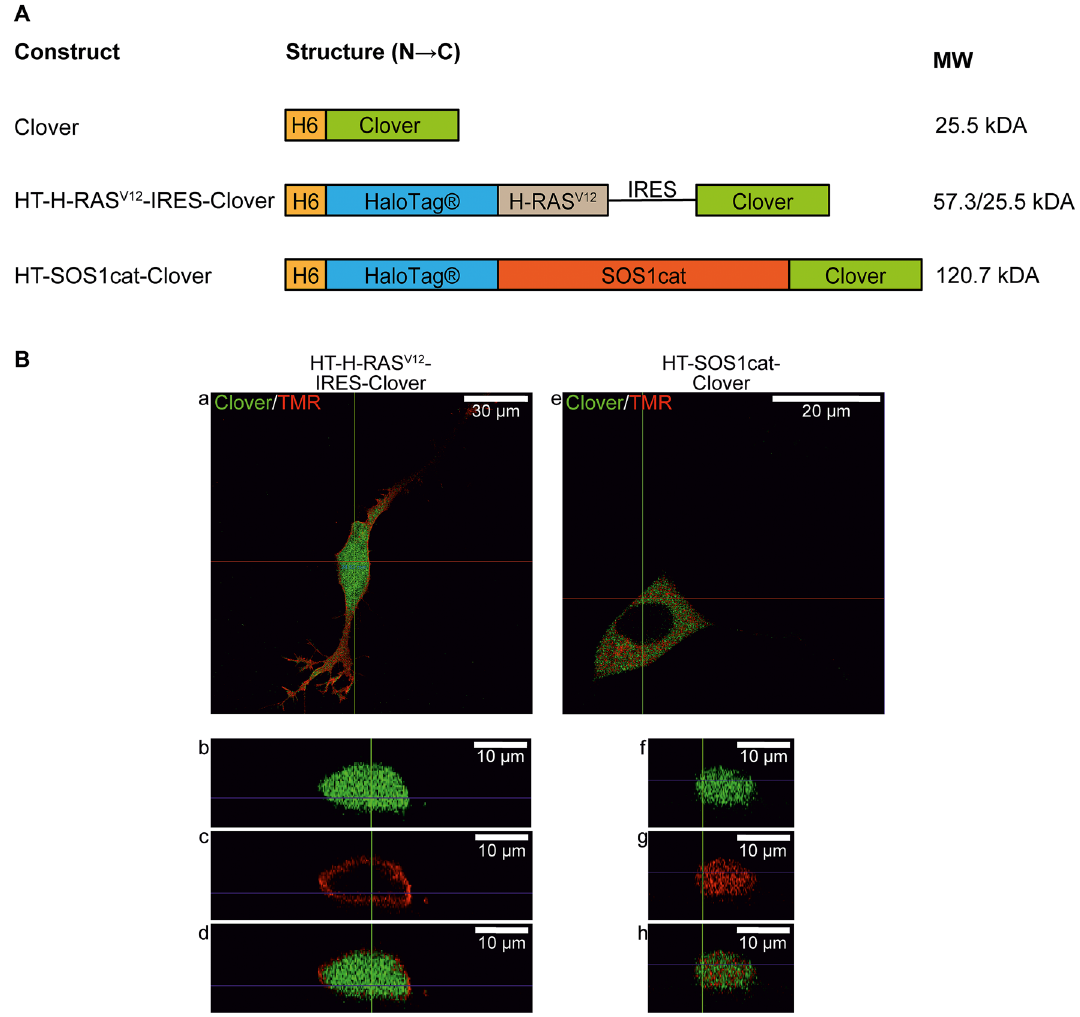
Figure 2. Domain structures of the constructs and intracellular distribution of expressed recombinant fusion proteins. ( A ) Constructs of the proteins. H6 poly(6)histidine tag, H-RAS V12 Harvey-RAS V12 , IRES Internal Ribosome Entry Site, SOS1cat catalytic domain of son of sevenless 1. ( B ) Confocal imaging of SH-SY5Y cells transfected with either HT-H-RAS V12 -IRES-Clover (a–d) or HT-SOS1cat-Clover (e–h) after in-cell binding of the red-fluorescent cell-permeable dye TMR-HTL 2 days after the transfection. Overlay images derived from green and red fluorescence channels are shown (a,e), and cross-sections indicated by the horizontal red line confirm that Clover is distributed equally in the cytoplasm and nucleus of HT-H-RAS V12 -IRES-Clover- transfected cells (b,d), whereas HT-H-RAS V12 is exclusively located at the plasma membrane (c,d). In cells transfected with HT-SOS1cat-Clover, the Clover and TMR fluorescence are colocalized in the cytoplasm (f–h). For HT-SOS1cat-Clover, exclusion from the nucleus is visible